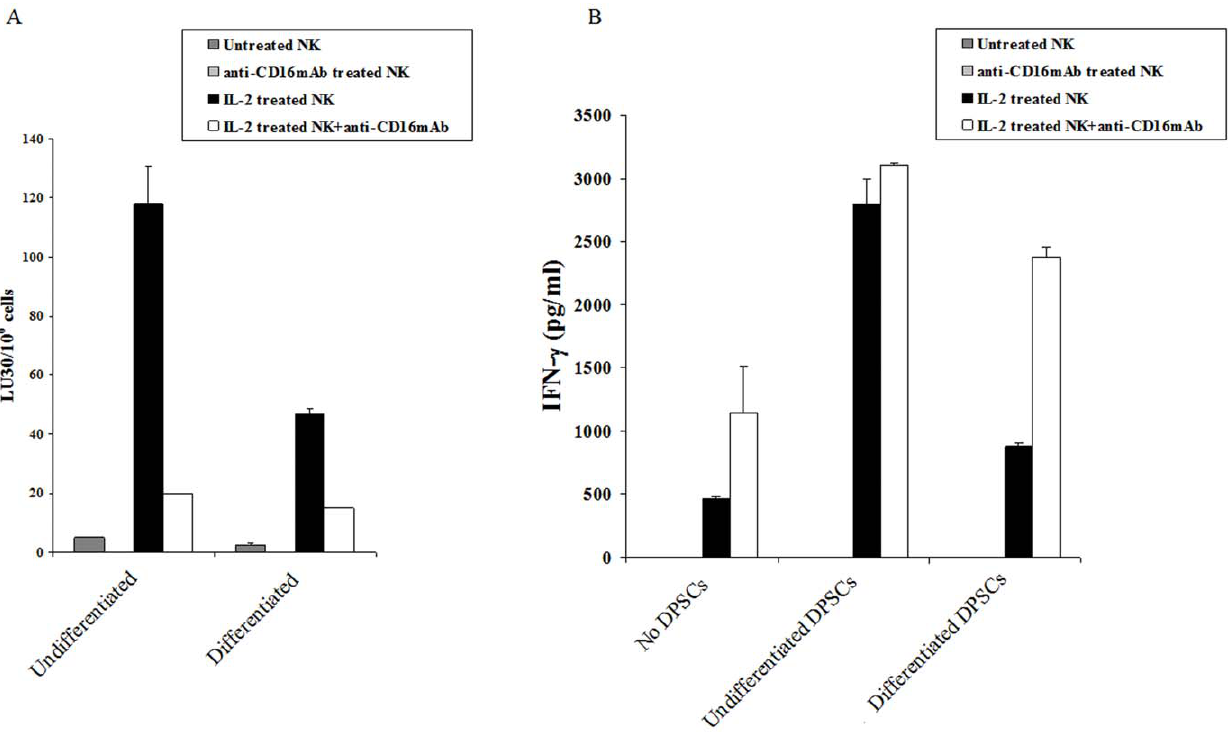
Figure 6. Undifferentiated DPSCs are significantly more sensitive to lysis by IL-2 treated NK cells and trigger increased secretion of IFN- c from the NK cells than their differentiated counterparts. NK cells (1 6 10 6 /ml) were left untreated or treated with IL-2 (1000 units/ml), or anti-CD16 mAb (3 m g/ml) or a combination of IL-2 (1000 units/ml) and anti-CD16 mAb (3 m g/ml) for 12–24 hours before they were added to 51 Cr labeled undifferentiated and differentiated DPSCs, and NK cell cytotoxicities were determined using a standard 4 hour 51 Cr release assay. Lytic units 30/10 6 cells were determined using inverse number of NK cells required to lyse 30% of the hDPSCs 6 100. Passage 8 differentiated and undifferentiated hDPSCs were used ( A ). Undifferentiated hDPSCs and those differentiated to odontoblasts at (1 6 10 5 /ml) were cultured with and without untreated NK cells or IL-2 (1000 units/ml), or anti-CD16 mAb (3 m g/ml) or a combination of IL-2 (1000 units/ml) and anti-CD16 mAb (3 m g/ml) treated NK cells at 1:1 ratio and after two days of incubation the supernatants were removed and subjected to specific ELISA for IFN- c ( B ). One of three representative experiments is shown in this figure.